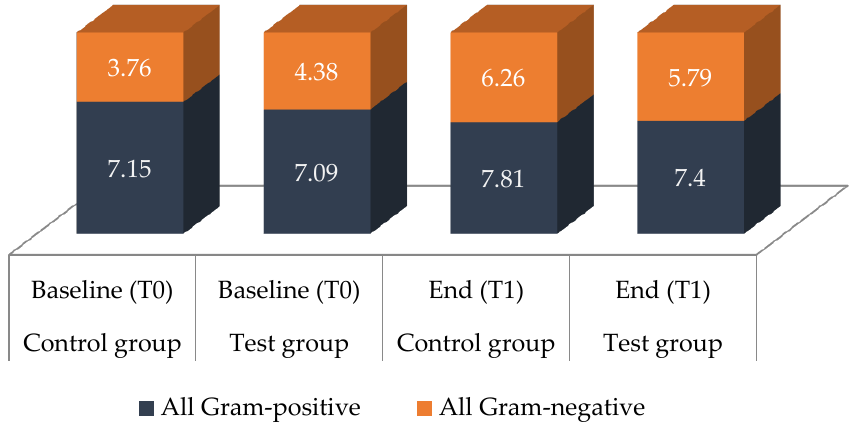
Figure 3. Gram-negative and Gram-positive species detected in saliva. Bacterial counts of Gram-negative and Gram-positive bacterial species for the test group and the control group at baseline (T0) and after 36 months (T1); values are given as means in log10 CFU/mL; n = 16 for each group. Within one group, from baseline to the end of the study, significantly higher counts of several species and subgroups of species were found in the control group (Figures